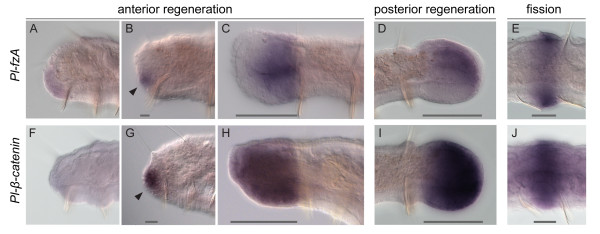
Expression of two Wnt/β-catenin pathway genes during regeneration and fission. Whole mount in situ hybridizations of Pl-fzA (A-E) and Pl-β-cat (F-J) show that both genes are expressed in the developing regeneration blastema as well as in new tissues forming by fission. (A-D) Following anterior amputation, Pl-fzA expression is not detectable (or only faintly so) before a blastema forms (A: 12 hours post amputation (hpa)), begins to be expressed in the early blastema (B: 1 day post amputation (dpa)) and persists through mid-stages of regeneration (C: 2 dpa). Pl-fzA is expressed in a similar fashion during posterior regeneration (D: 2 dpa). (F-I) Following anterior amputation, Pl-β-cat is similarly not detectable (or only faintly so) prior to blastema formation (F: 12 hpa), begins to be expressed in the early blastema (G: 1 dpa), and persists through mid-stages of regeneration (H: 3 dpa). Pl-β-cat is also expressed during posterior regeneration (I: 2 dpa). (E, J) During fission, both genes are expressed in developing fission zones (E, J: early fission - stage B), the transverse regions of tissue from which a new head and tail form (see Figure 1). All panels are lateral views with anterior to the left. Dark gray bars mark the extent of new tissue, i.e., the regeneration blastema or fission zone. Arrows point to early phase of expression of each gene on day 1.